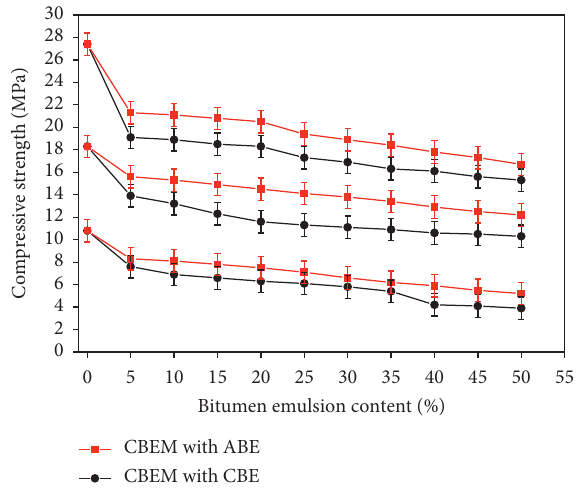
Figure 4: Influences of bitumen emulsion content on the com- pressive